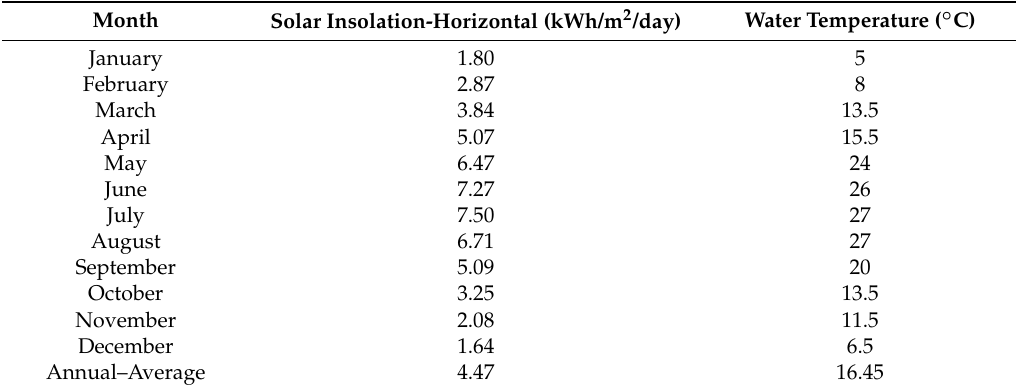
Table 1. Horizontal insolation and surface temperature of lake’s water for an average day in each month. Month Solar Insolation-Horizontal (kWh/m 2 /day) Water Temperature ( ◦ C) January